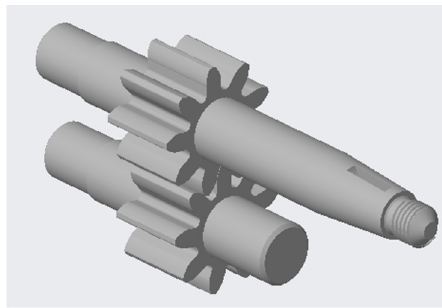
Figure 6. View of drive and idle gears.